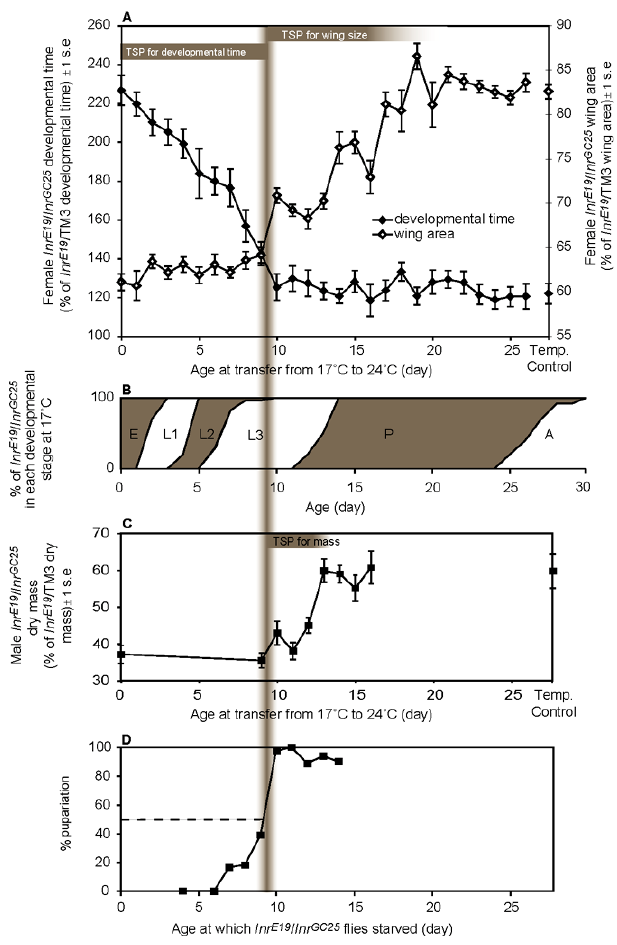
Figure 3. Suppression of Inr Expression in Inr E19 /Inr GC25 Flies Affects Developmental Time and Adult